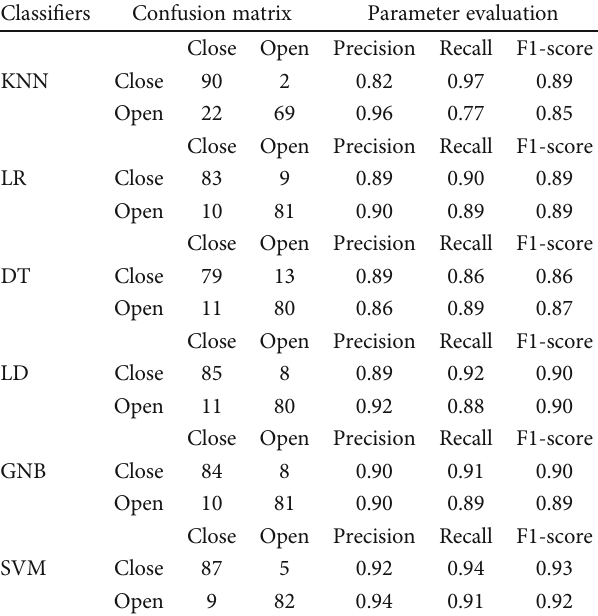
Table 5: Confusion matrix and parameter evaluation of classi fi ers applied to extracted features by